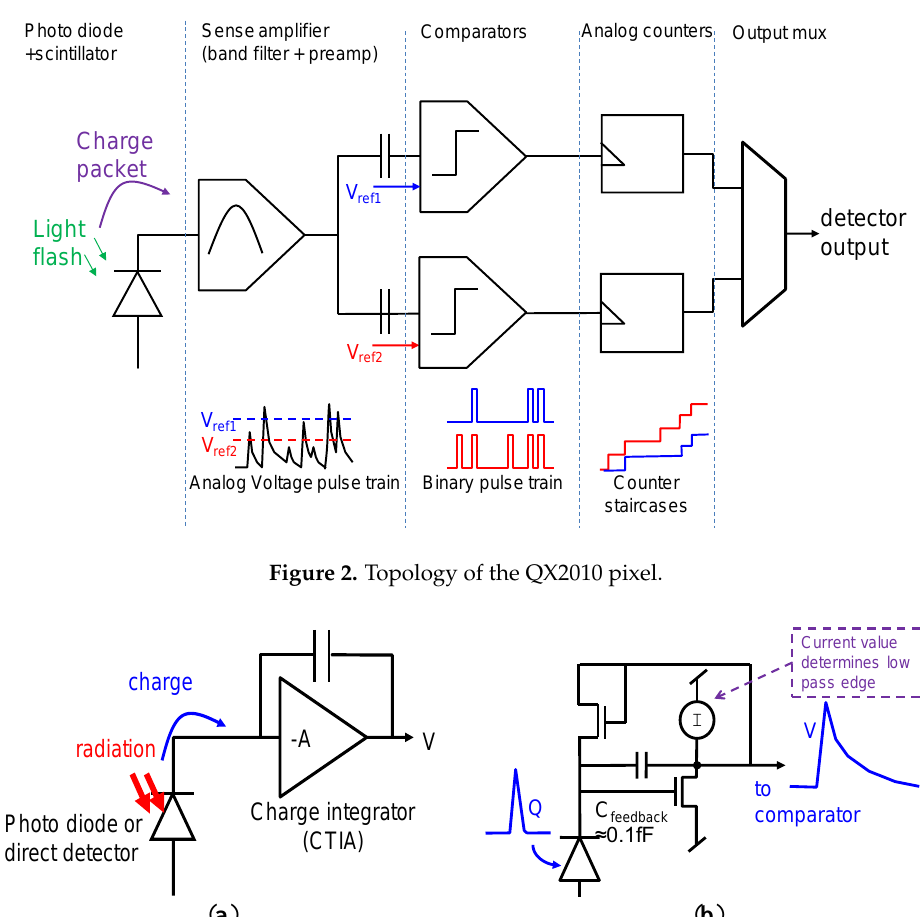
Figure 3. ( a ): General concept of a charge sensitive “charge trans-impedance amplifier” (CTIA). ( b ): CTIA with resistive feedback implemented as a MOSFET, becoming a “pulse shaper.”